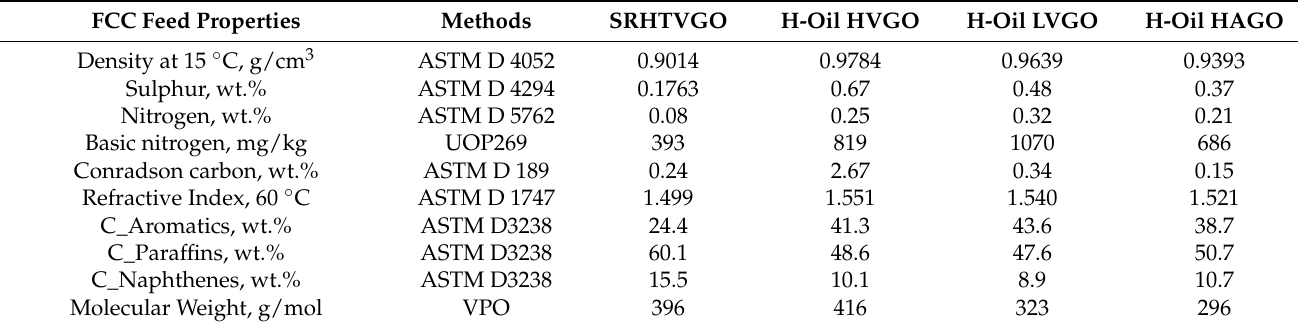
Table 1. Properties of the FCC feed streams studied in this